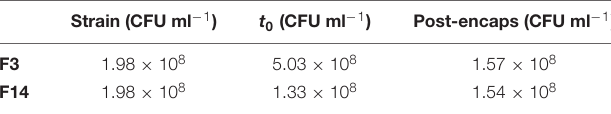
TABLE 3 | Evaluation of Lactobacillus paracasei CBA L74 viability before and after encapsulation